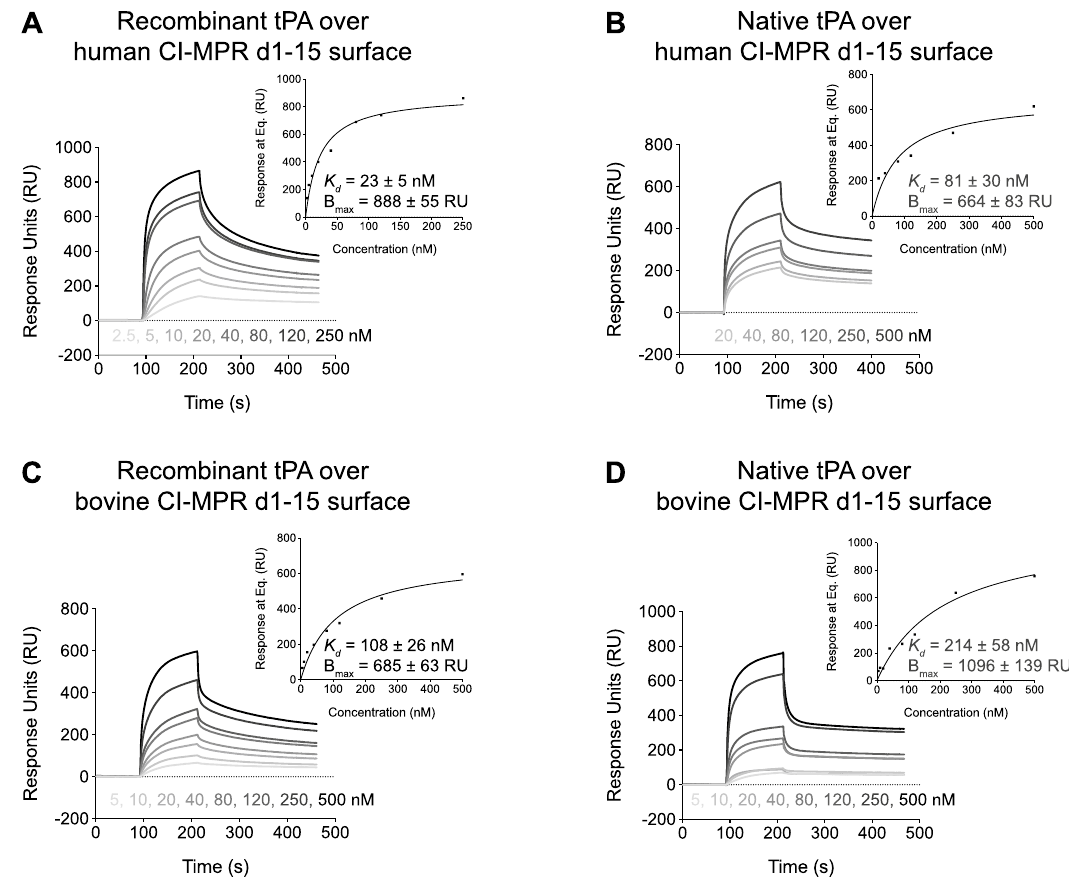
Figure 1. tPA from two sources binds the extracellular region of CI-MPR from two species. ( A , B ) Human CI-MPR d1–15 was biotinylated at the C-terminus and immobilized to a streptavidin sensor chip. Sensorgrams are shown for various concentrations of injected recombinant tPA ( A ) or various concentrations of injected native tPA ( B ). ( C , D ) Bovine CI-MPR d1–15 was amine coupled to a sensor chip. Sensorgrams are shown for various concentrations of injected recombinant tPA ( C ) or various concentrations of injected native tPA ( D ). In panels ( A – D ), the inset plots show the response at equilibrium (Eq.) with respect to tPA concentration. Data are fit using a one site specific binding fit, and K d and B max are reported below the curve (best fit value ± SEM). CI-MPR d1–15 cation-independent mannose 6-phosphate receptor domains 1–15, tPA tissue plasminogen